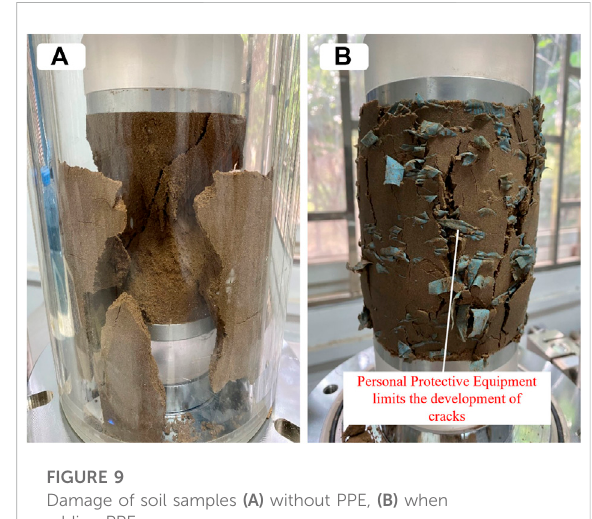
FIGURE 9 Damage of soil samples (A) without PPE, (B) when adding